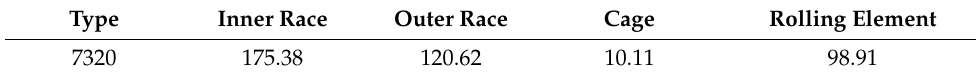
Table 4. Fault characteristic frequencies.